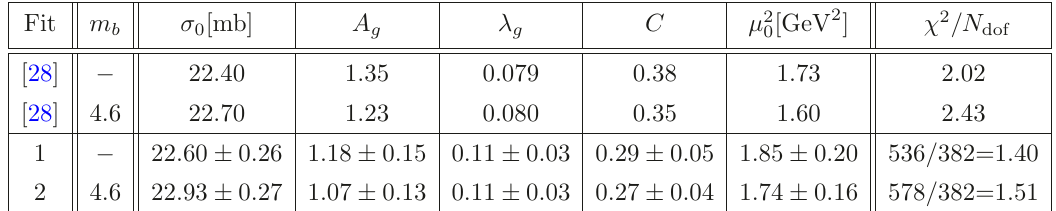
Table 3 . The results of the fits to the HERA data for Q 2 650 GeV 2 with N p = 387 points, using ≤ the dipole cross section (2.9) with the scale (2.17). The quark masses m l = 0 and m c = 1 . 3 GeV. χ 2 /N dof computed with the parameters from [28] and the scale (2.10) are given in the first two rows. The parameters of Fit 2 are used for further